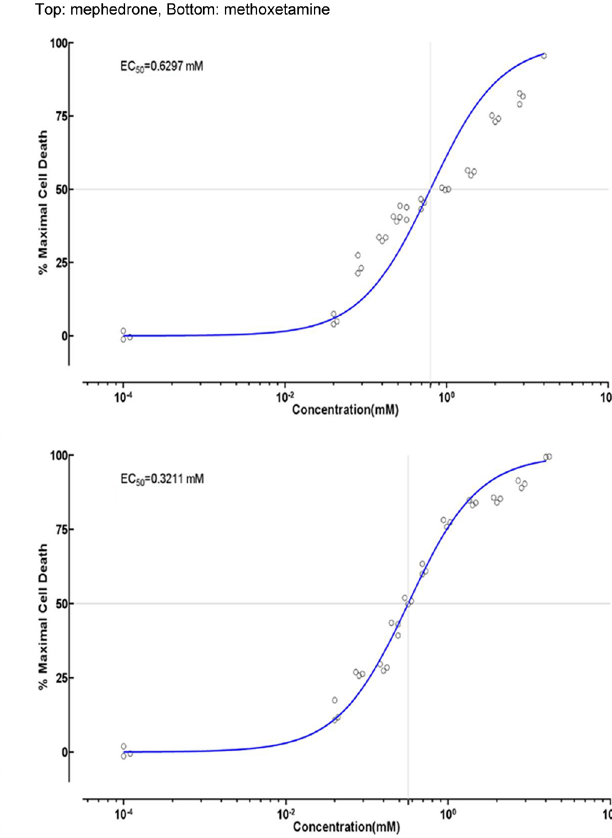
Figure 6: Relative drug concentrations of selected NPS to the pri - mary drug concentration after 90 min and 24 h of incubation with HepaRG ™ . Top: mephedrone. Bottom: methoxetamine.